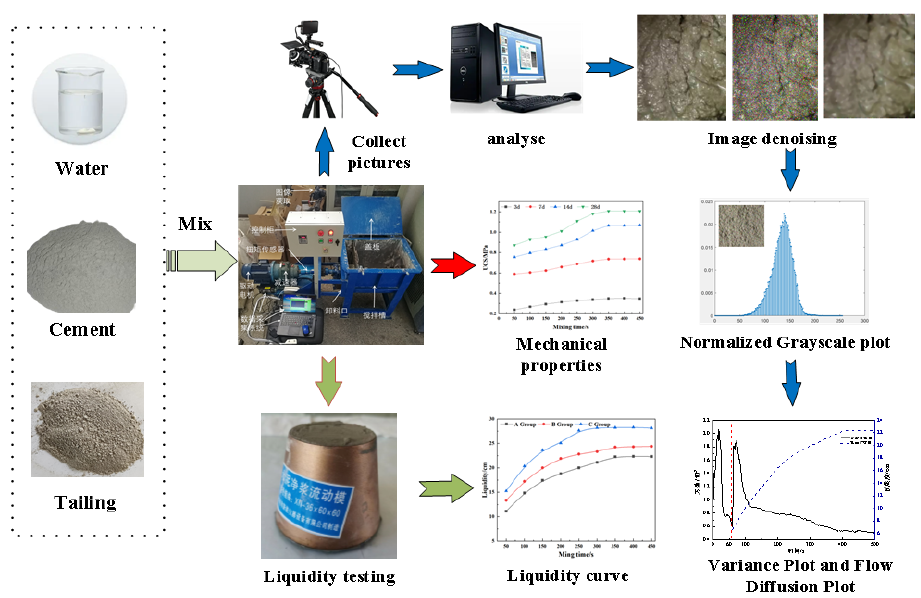
Figure 3. Experimental process.